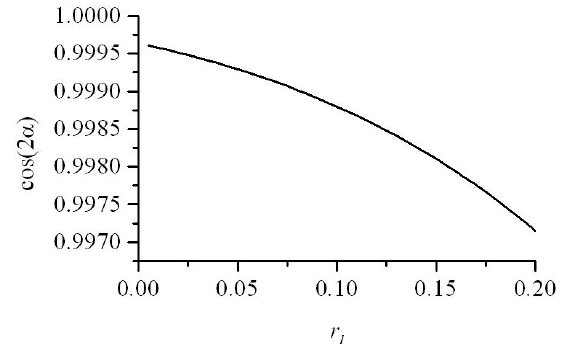
Fig. 2. Cosine of phase difference between the two eccentric rotors along the curve H 0 = 0 in Fig.